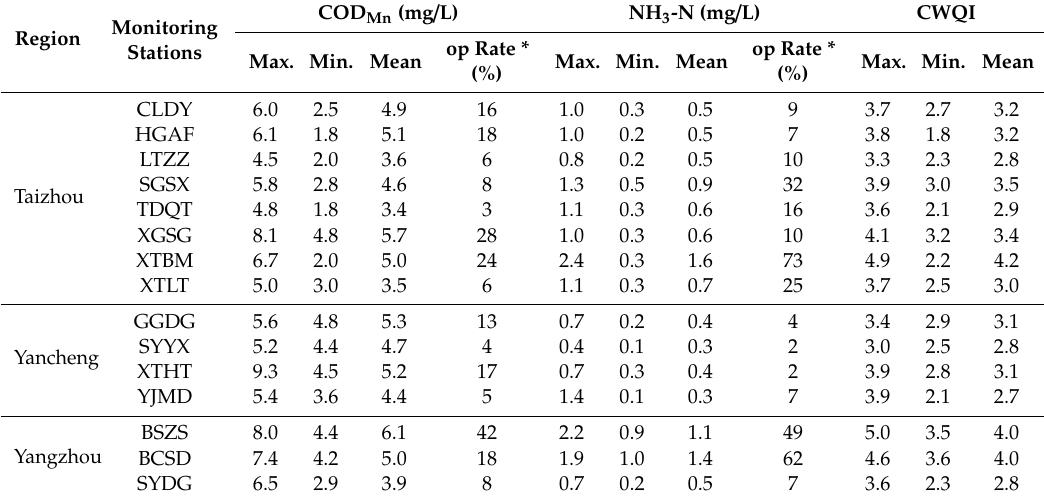
Table 4. Characteristic values of annual mean water quality of each